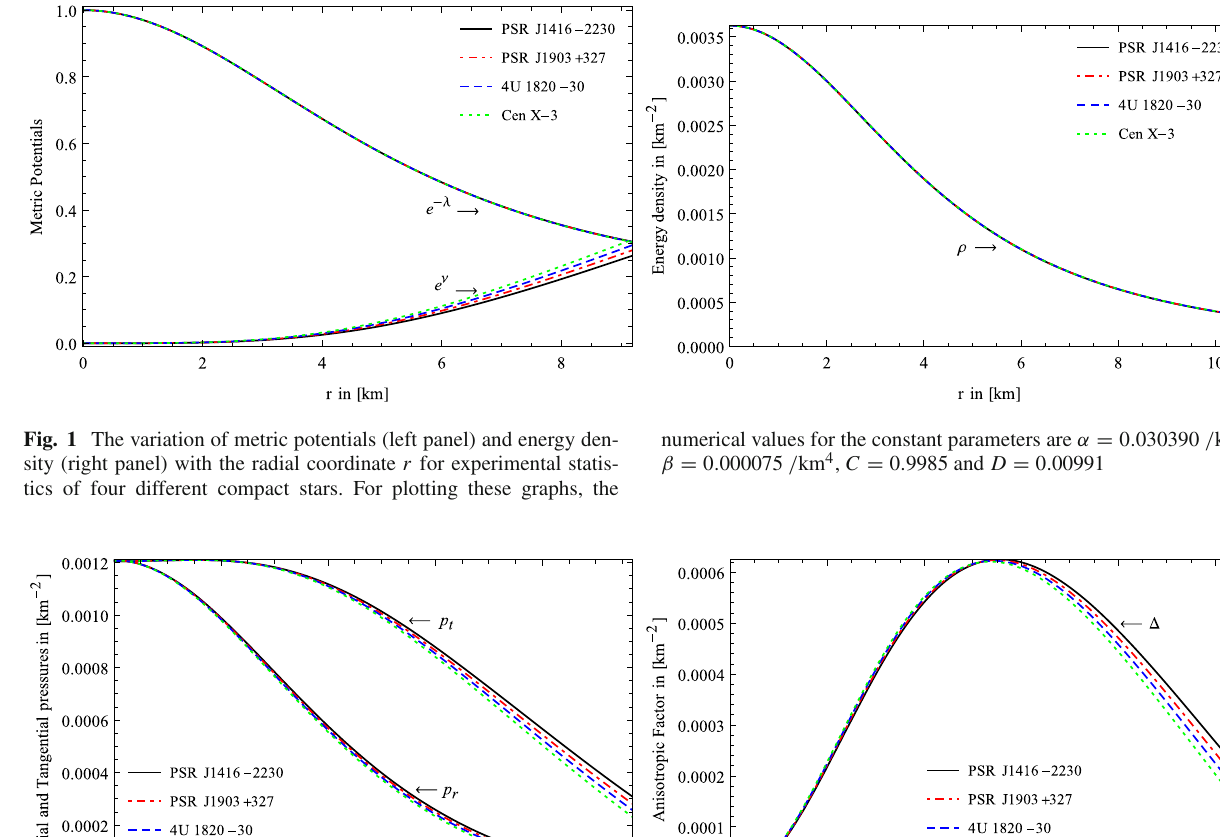
graphs, the numerical values for the constant parameters are α = 0 . 030390 / km 2 , β = 0 . 000075 / km 4 , C = 0 . 9985 and D = 0 .